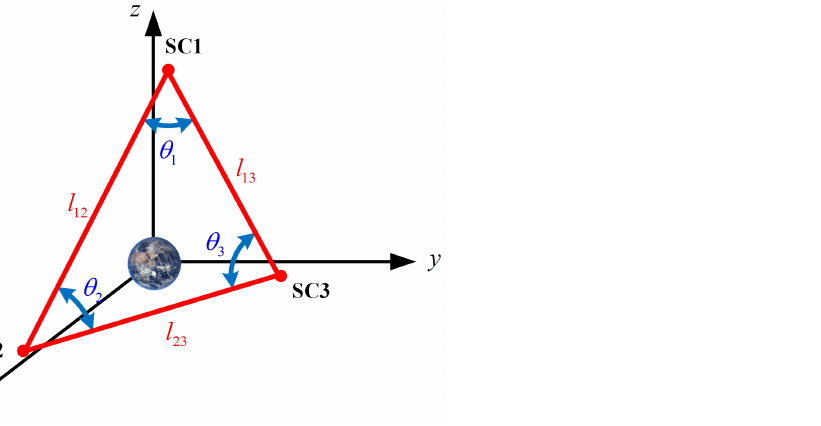
Figure 3. An illustration of the arm length and the breathing angle. SC1, SC2 and SC3, respectively, represent the spacecraft 1, spacecraft 2 and spacecraft 3.